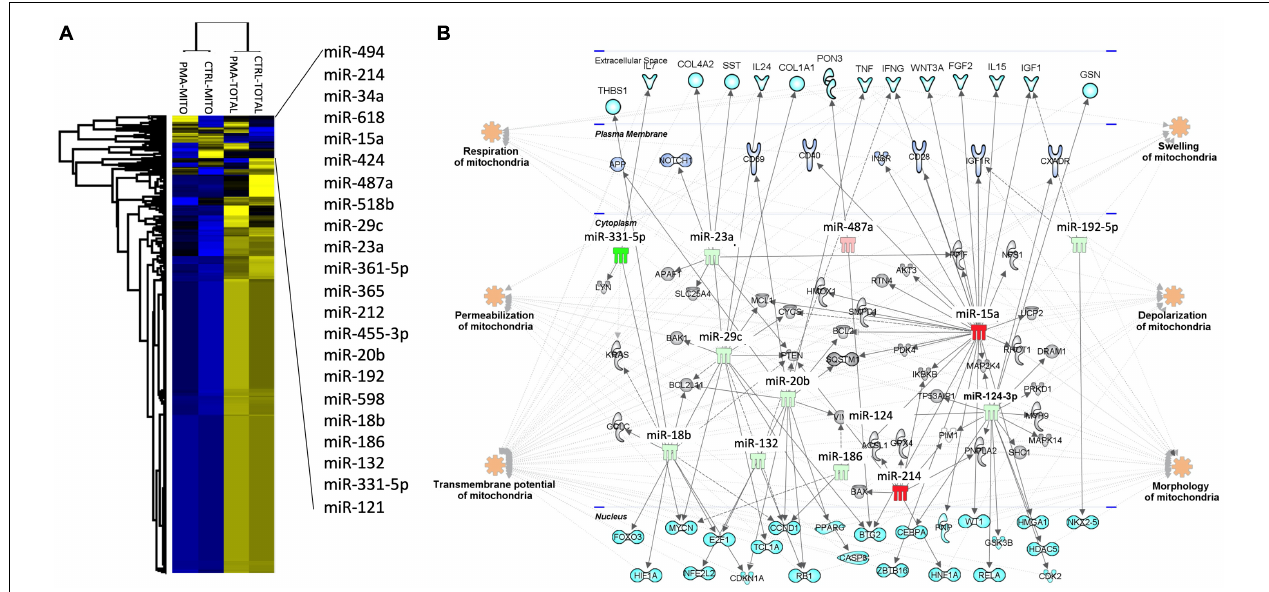
FIGURE 2 | Macrophage mitomiRs signature: The human monocytic cell line THP-1 cells was differentiated into THP-1 derived macrophages with 40 ng/mL phorbol 12-myristate 13-acetate (PMA) over-night in RPMI 1640 Medium GlutaMAX TM Supplement with 10% FBS at 37 ◦ C and 5% CO2. Total cellular and mitochondrial enrichment fractions were prepared at 4 ◦ C using a MACS Mitochondria kit (Miltenyi), and total RNA including miRNAs were extracted using miRNeasy kit (Qiagen). miRNA quantification was performed using the TaqMan R (cid:13) Array Human MicroRNA Card Set v3.0 (Applied Biosystems), according to the manufacturer’s instructions. (A) Using Perseus software, a non-supervised hierarchical analysis of the distribution of total and mitochondria enrichment cell fractions based on relative log2 expression of 762 human miRNAs significantly modified by PMA compared to untreated controls. Yellow and blue represent the increase and decrease in expression, respectively. (B) miRNA-mRNA networks generated with Ingenuity Pathway Analysis (IPA) for the 22 macrophage-specific mitomiRs. IPA analysis was performed to investigate Mt-miRNA associated genes, filters were set to include experimentally observed or high-confidence-predicted miRNA-mRNA interaction partners, associated with mitochondria biological pathways. miRNAs were colored in red or green depending on whether they were upregulated or downregulated in mitochondria fractions following macrophage differentiation, respectively.